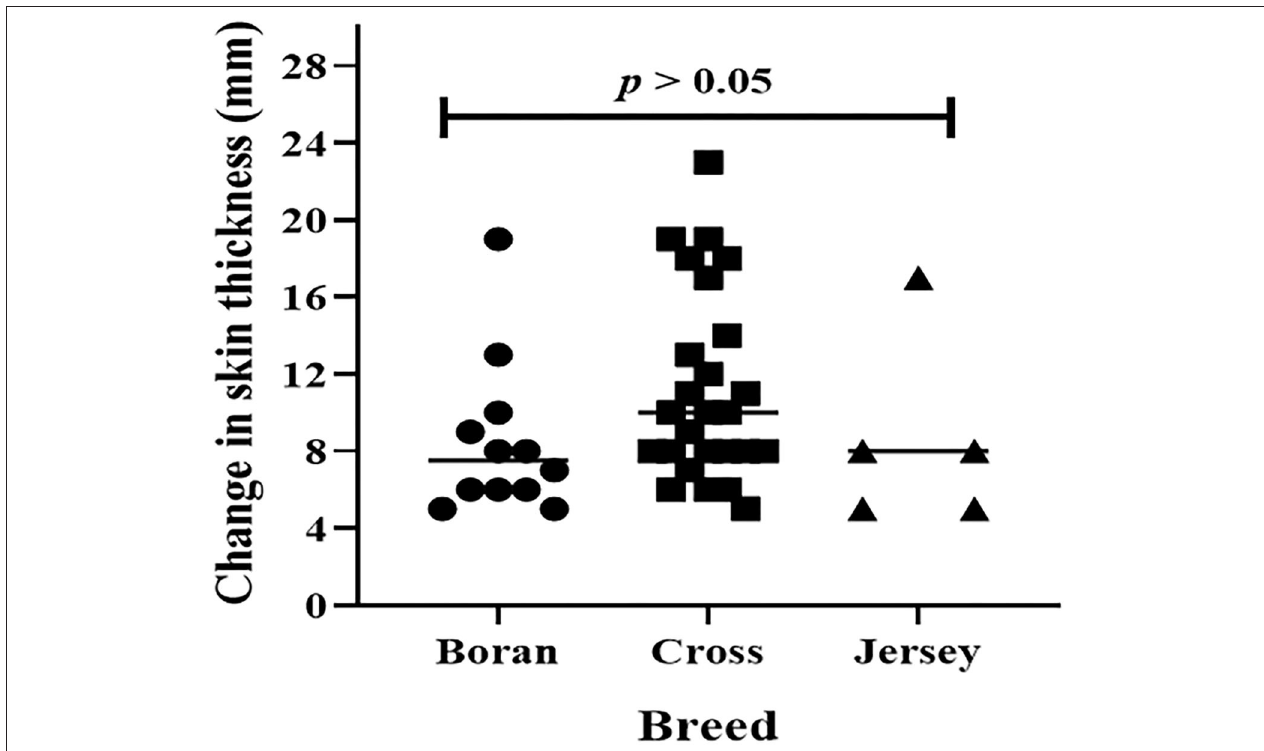
FIGURE 3 | Skin reaction to purified protein derivatives, PPD (B-A) in 43 dairy animals. The horizontal lines represent a median of skin reactions in each breed. Change in skin thickness was compared among Boran, cross, and Jersey breeds using Kruskal-Wallis statistical test. There was no significant [ χ 2 (2) = 4.8, p > 0.05] difference among the